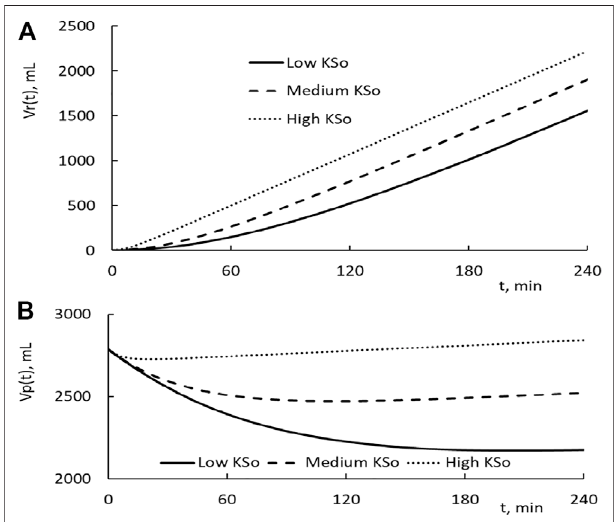
FIGURE3|(A) Temporalchangesin fl uidrestitutionvolumeVr(t)overthe courseofHD.ThepatientstakingtheHDhavelow,medium,andhigh fi ltration coef fi cient KSo. The plasma volume of the patient is set at 2,785 ml, and the HD is performed with the relative extraction Δ Ve/Vp as 77.8%. (B) Temporal changes in plasma volume induced by HD.